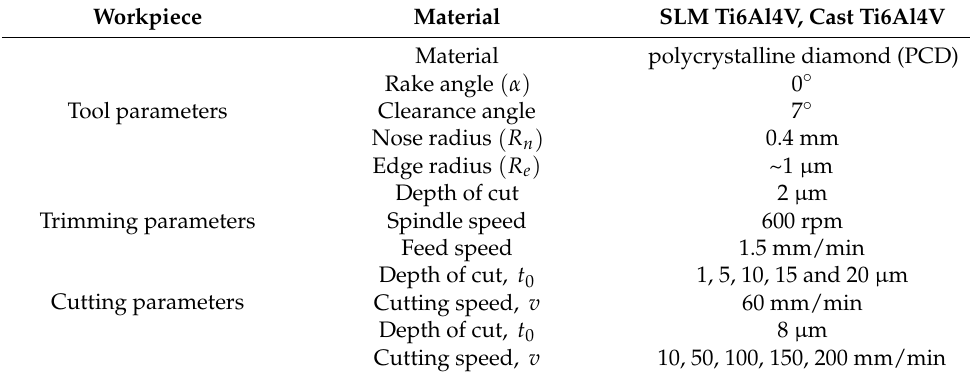
Table 1. Details of the workpiece parameters and machining